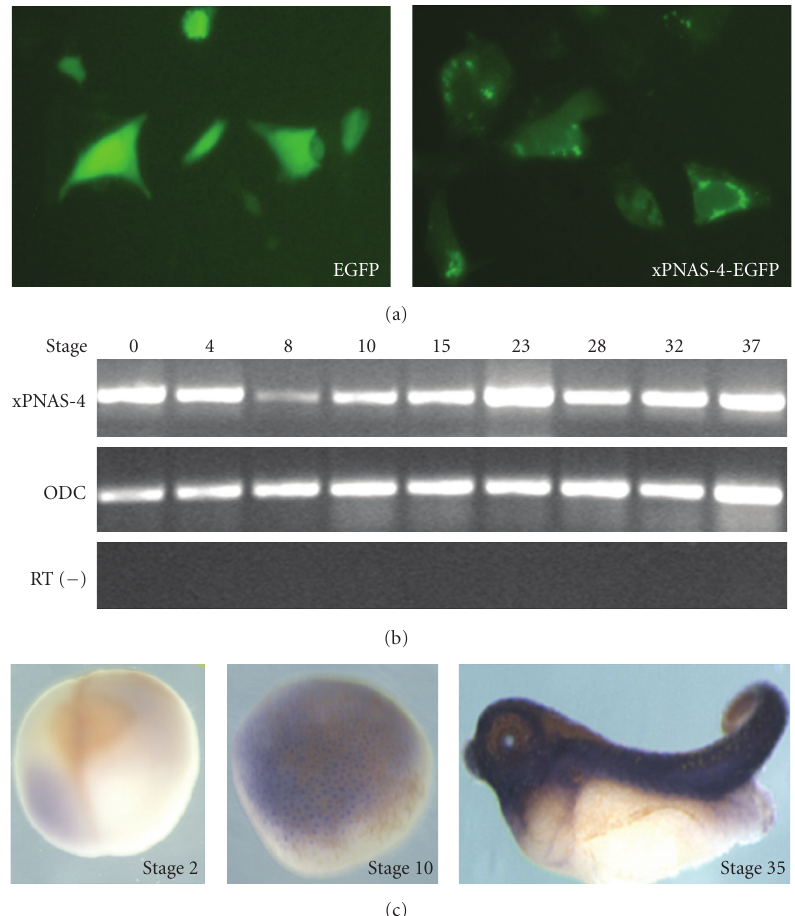
Figure 2: Cellular localization, and temporal and spatial expression patterns of xPNAS-4. (a) HEK293 cells were transfected with pEGFP- N1 or pEGFP-N1-xPNAS-4 plasmids as explained in materials and methods. Left: pEGFP-N1 transfected cells (200 × ); Right: pEGFP-N1- xPNAS-4 transfected cells (200 × ) . (b) Analysis of the temporal expression pattern of xPNAS-4 gene by semiquantitative RT-PCR. ODC: X. laevis ornithine decarboxylase as internal control gene. RT (–): control reverse transcription without template. (c) Whole mount in situ hybridizations showing the spatial expression pattern of xPNAS-4 gene. The upper-left image shows the expression pattern of the xPNAS- 4 gene in a stage-2 embryo. The upper-right image shows the expression pattern of the xPNAS-4 gene in a stage-10 embryo (beginning of gastrulation). An ubiquitous expression pattern (purple staining) can be seen. The lower image shows the expression pattern of the xPNAS-4 gene at stage 35. xPNAS-4 transcripts were present in the head, dorsal neural tissue, and prospective heart.